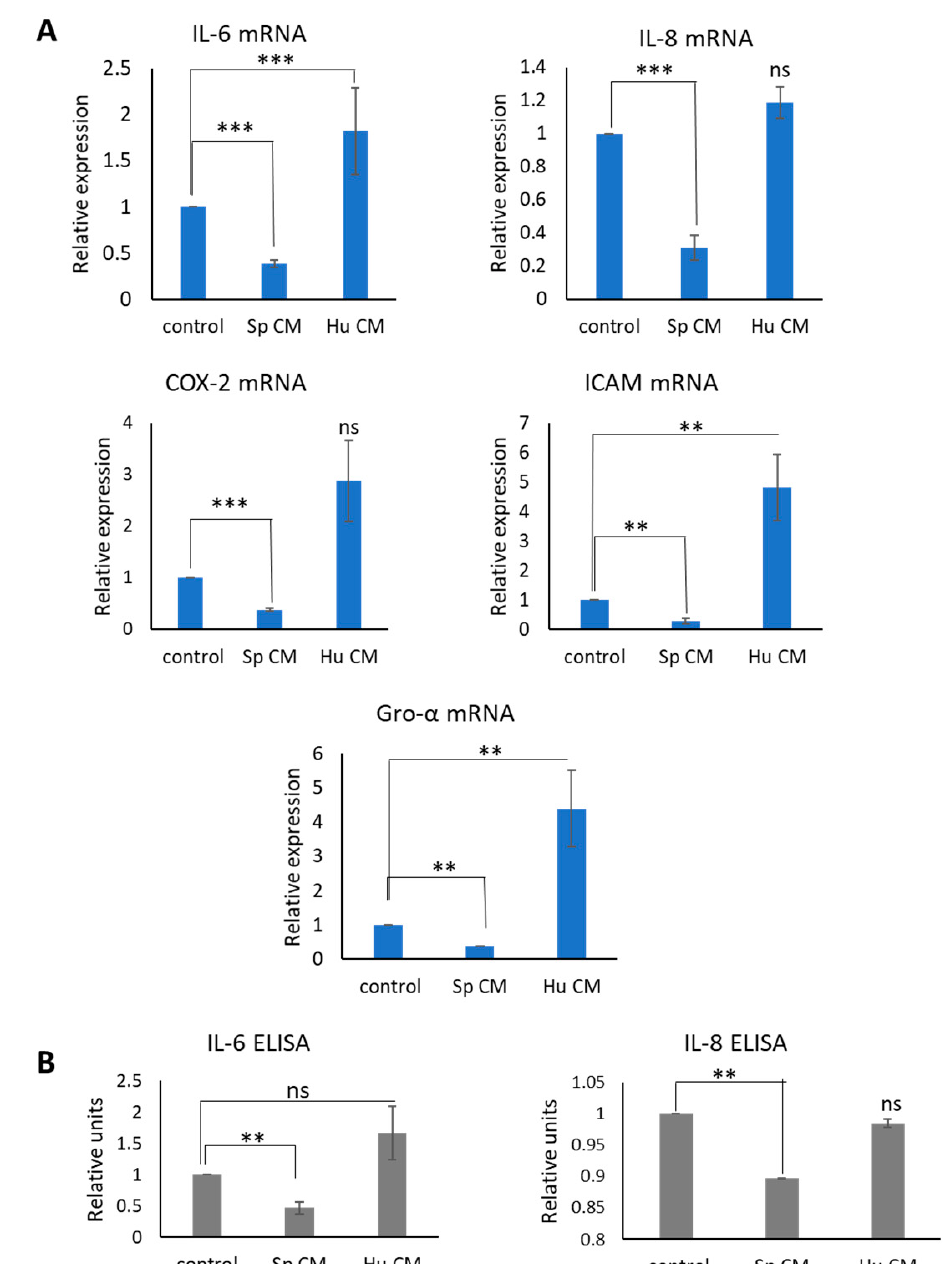
Figure 4. The expression and secretion of inflammatory mediators in MDA-MB-231 cells under exposure to Spalax (Sp) or human (Hu) CMs. ( A ) The mRNA expression rates were quantified by using qRT-PCR. Representative data for COX-2 IL8, IL6 and GRO- α and ICAM-1 are shown. Experiments were performed in triplicates and repeated at least three times. Data are presented as mean ± SE; ** p ≤ 0.01; *** p ≤ 0.001, differences between treated MDA-MB-231 cells vs. untreated; “ns”, not significant p value ( B ) MDA-MB231 were incubated for 4 days with CM from senescent Spalax and human fibroblasts, thereafter cells were washed and incubated for further 24 h in fresh serum-free media for ELISA analysis. Experiments repeated at least three times with CMs received from different Spalax individuals and from different late passage- CMs of human fibroblasts.